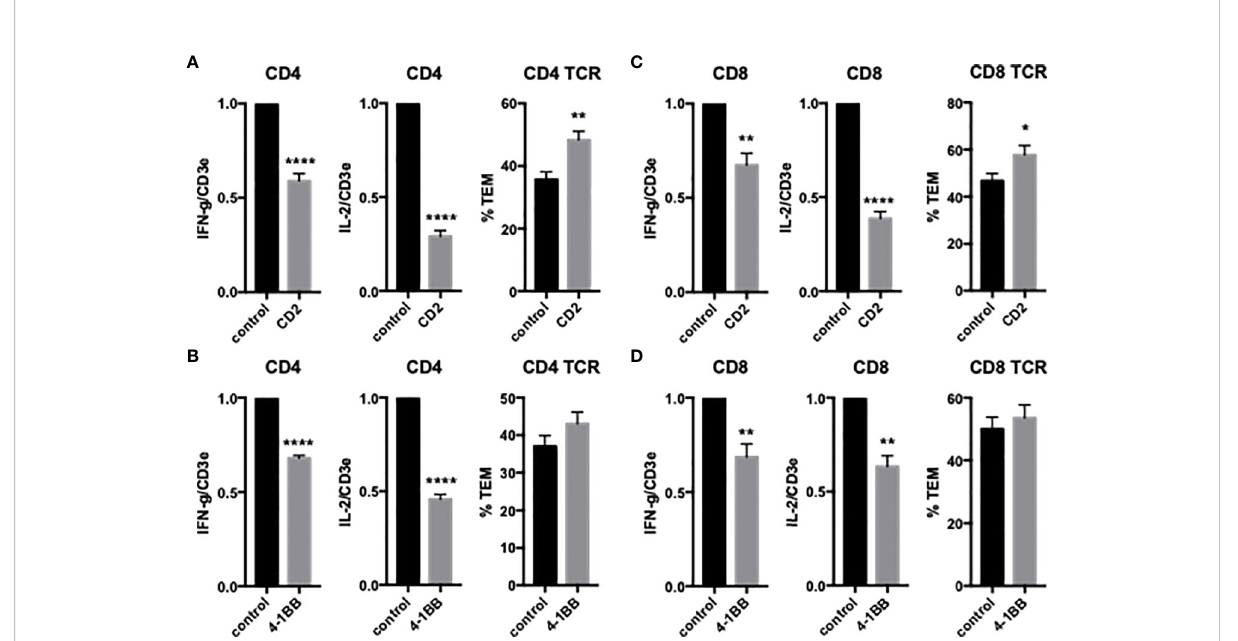
FIGURE 1 Effects of CD2 and 4-1BB costimulatory molecules on cytokine expression and TCR-TEM of freshly isolated CD4 and CD8 T EM . Blocking Abs to T cell CD2 (A, C) or 4-1BB (B, D) were added to T cells 30 min prior to addition to CIITA-transduced HDMEC activated with TNF 24 h, overlaid with TSST-1 30 min and assayed for cytokine expression by QRTPCR after 3 h (left graphs) and TCR-TEM after 50 min (CD4, A, B) and 30 min (CD8, C, D) fl ow by staining fi xed samples for V b 2TCR and analyzing TEM of V b 2TCR+ cells identi fi ed by fl uorescence and phase contrast microscopy to determine whether those cells have transmigrated or not (right graphs). *p<0.05; **p<0.01;